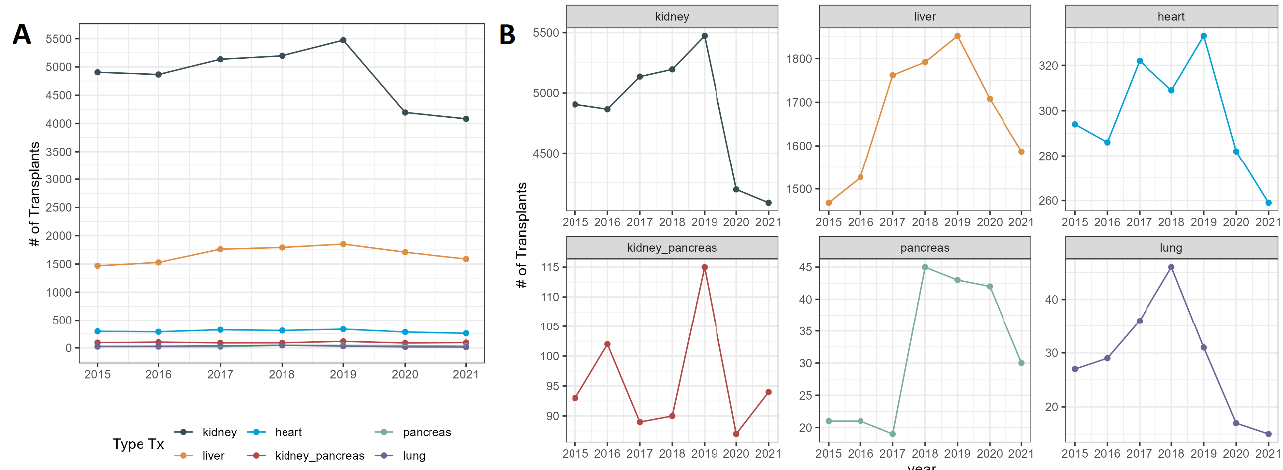
Figure 1. Total number of solid organ transplants performed in Brazil’s Unified Healthcare System (SUS) from 2015 to 2021. ( A ) All solid organ transplants; ( B ) individual graphs for each type of solid organ transplant. #: